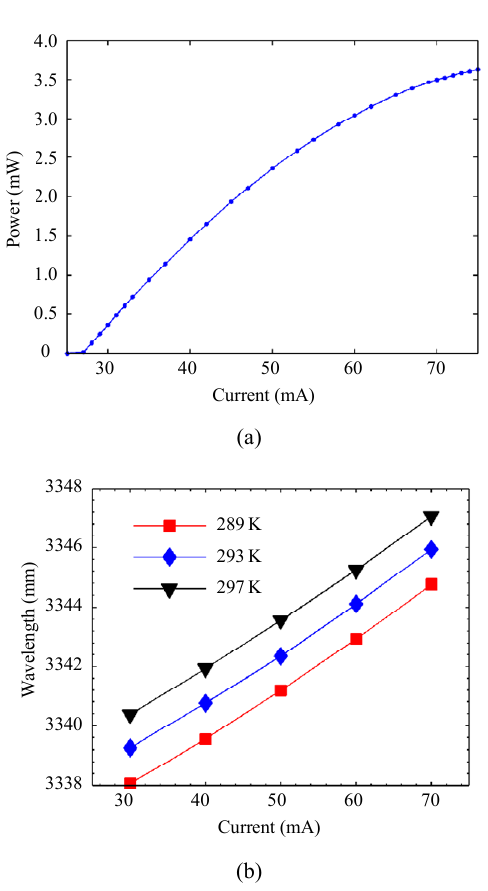
Fig. 3 Features of ICL laser: (a) measured P - I curve for ICL laser operating at 293 K and (b) emission wavelength of laser for different temperatures and driving